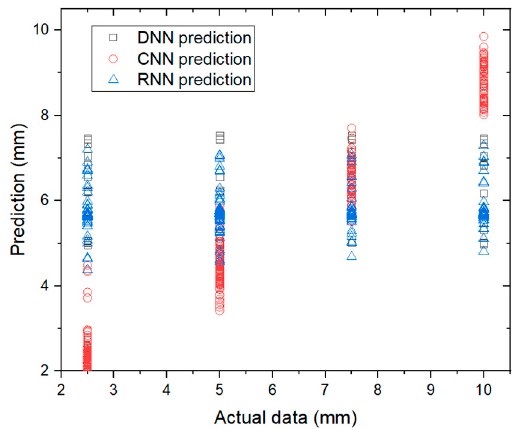
Figure 4. Actual data and prediction of dipped joint severity regression.